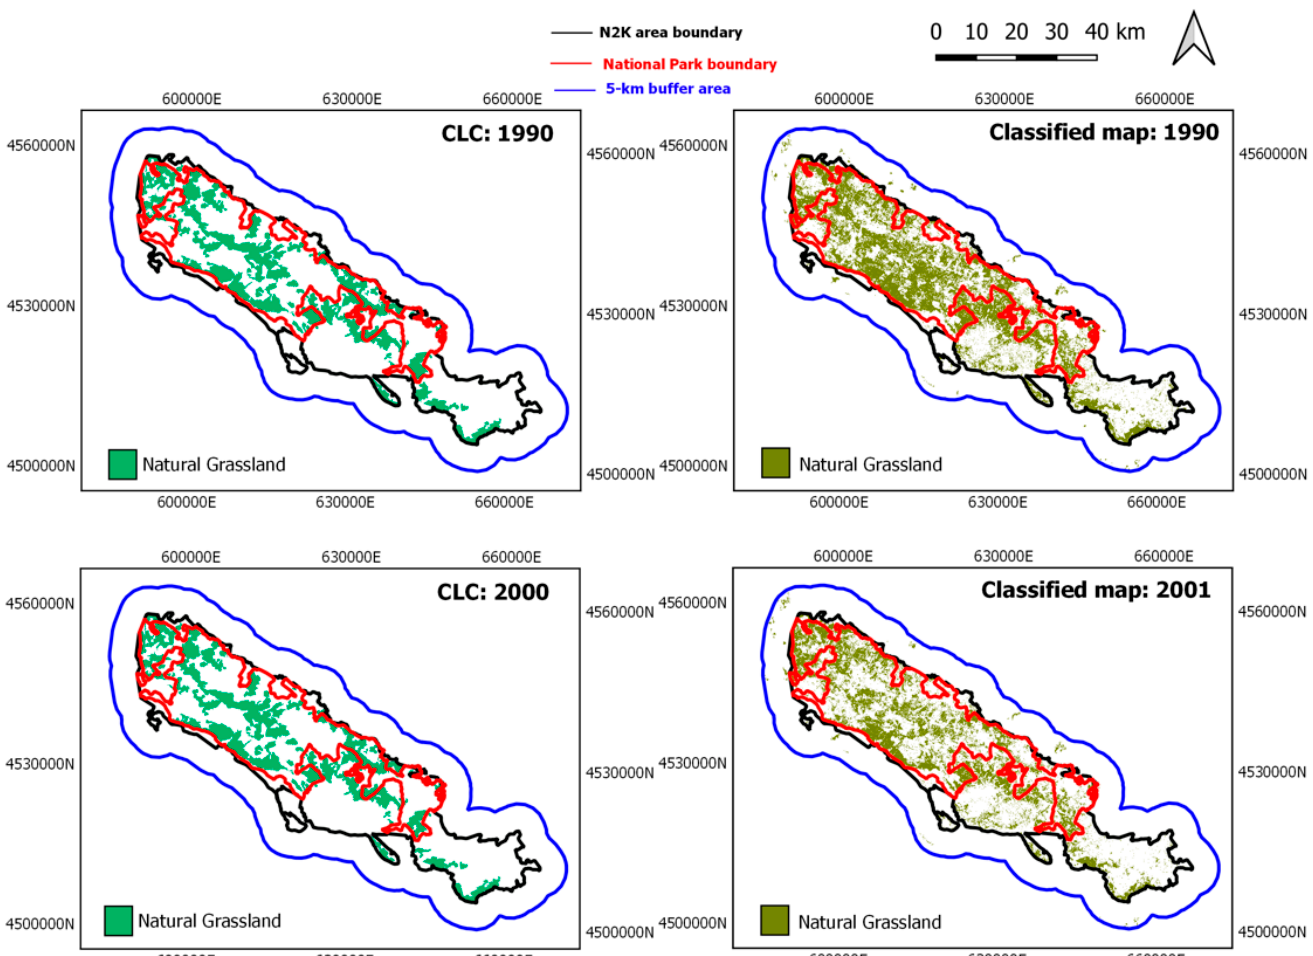
Figure 7. Grasslands classified mappings (30 m spatial resolution) for 1990 and 2001 on the right vs. CLC mappings (100 m spatial resolution) for 1990 and 2000 on the